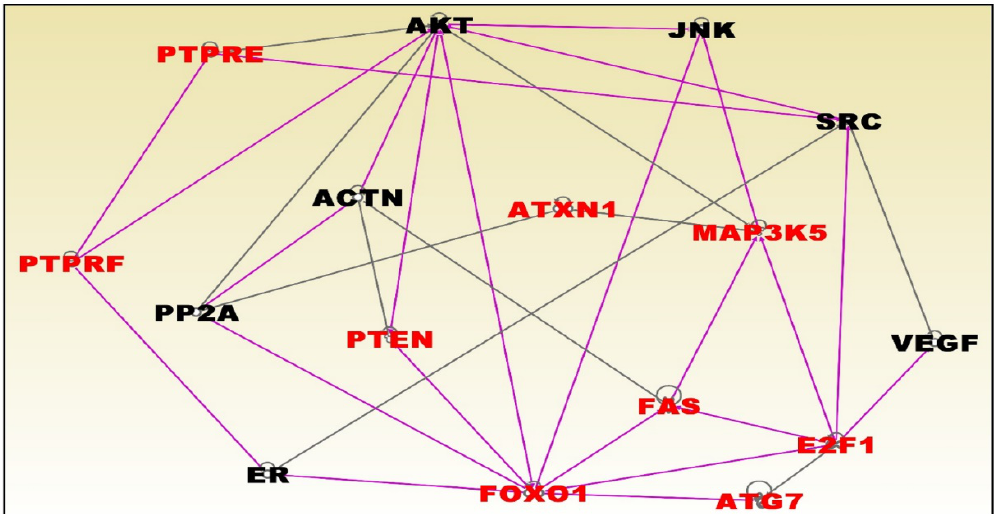
Figure 5. Molecular networks containing genes predicted to be significantly associated with obesity in premenopausal women. Network analysis was based on highly significantly differentially expressed genes ( p < 0.01) in red fonts. Gene symbols in red fonts were predicted to be highly significantly associated with obesity. Genes in black symbols are predicted to be functionally related to genes in red fonts. The pink and black lines denote the relationships between merged networks.